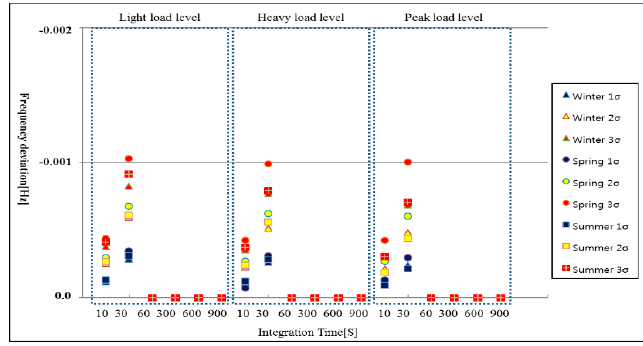
Figure 16. Frequency deviation distribution chart of all steel company (network model).